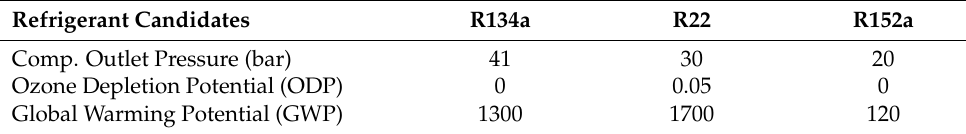
Table 1. Refrigerant